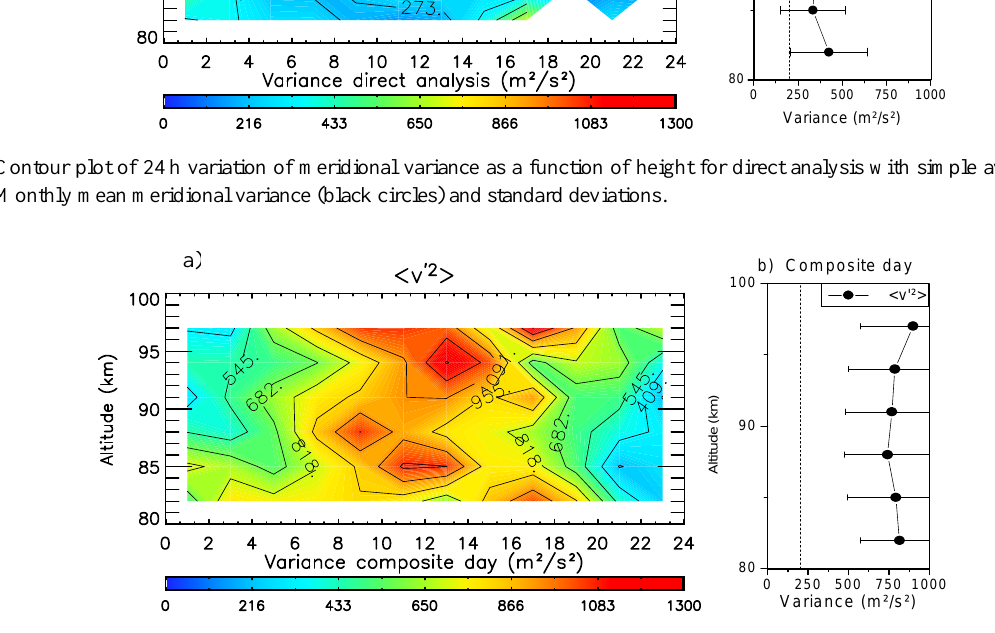
Fig. 3. As Fig. 2, but using the standard composite day